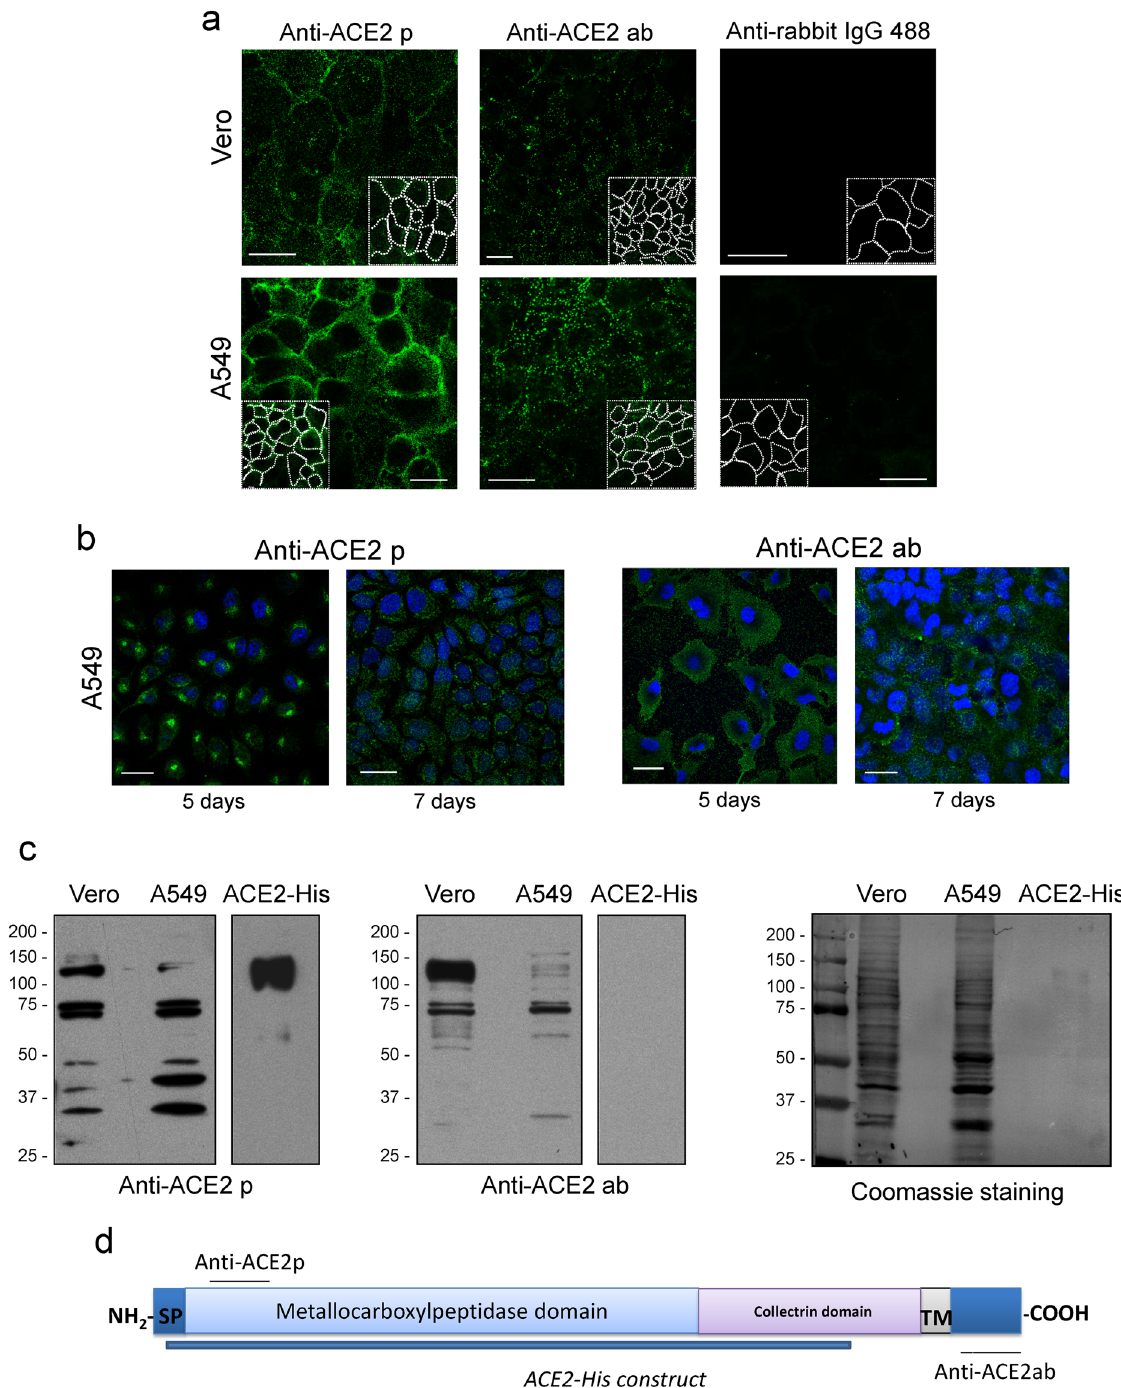
Figure 4. Immunodetection of ACE2. ( a ) Vero or A549 cells were incubated with the indicated anti-ACE2 antibodies prior to fixation. Right panels show the background of the secondary anti-rabbit IgG antibody. Insets show the cell contours. ( b ) A549 cells cultured for 5 days or 7 days after plating were stained with the indicated anti-ACE2 antibodies after fixation with 4% (w/v) PFA and permeabilization with 0.1% (v/v) Triton X-100 for 5 min. Nuclei were counterstained with DAPI. (p, rabbit polyclonal; ab, rabbit polyclonal antibody from Abcam). Bars, 20 μm. ( c ) Detection of ACE2 by western blot. Total cell lysates from the indicated cell types containing 30 μg of protein, or 100 ng of purified ACE2 protein (ACE2-His) were analyzed by SDS-PAGE followed by immunoblot with the indicated anti-ACE2 antibodies. Left panels show a long and a short exposure of the blot of cell lysates and recombinant protein, respectively. Middle panels show a short exposure in both cases. In the right panel, the total protein on blots was visualized by staining with Simply Blue. ( d ) Scheme depicting the sequence of ACE2, the location of the epitopes of the antibodies used and the region spanned by the recombinant protein. SP, signal peptide; TM, transmembrane